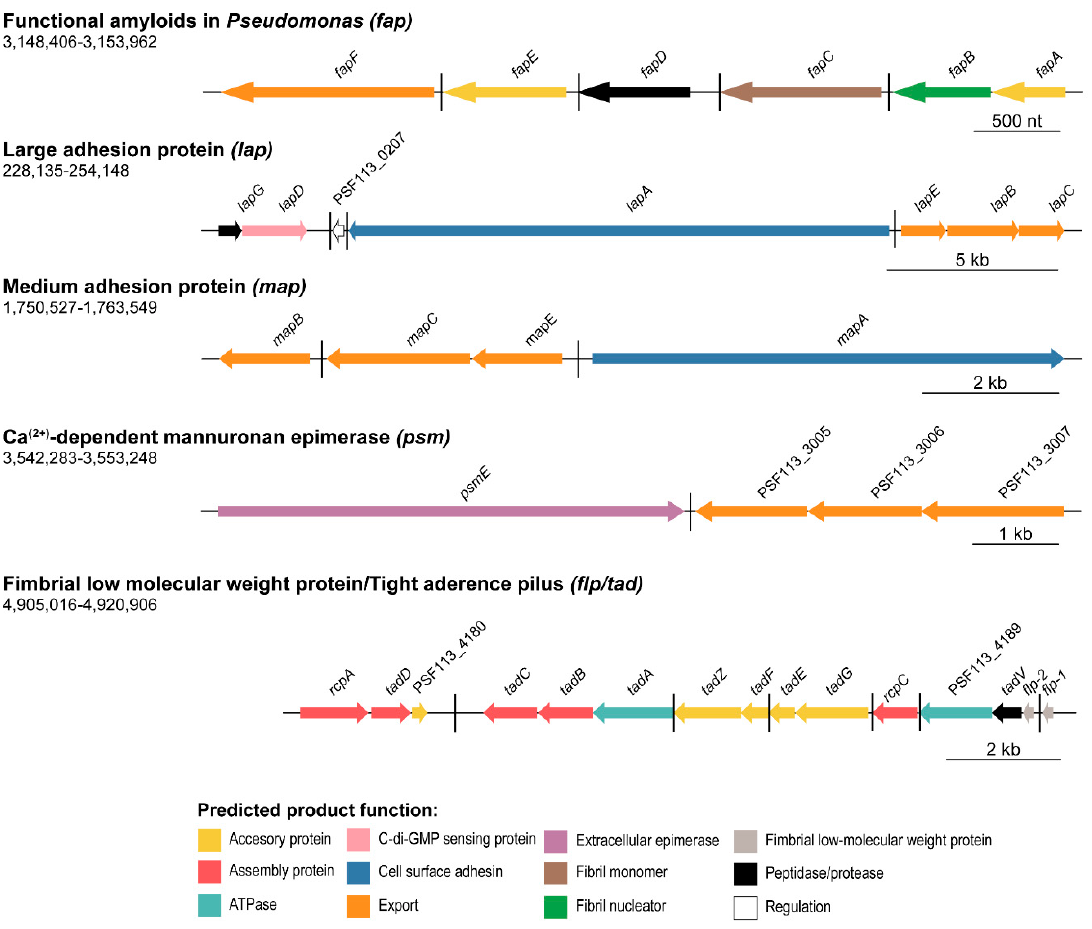
Figure 2. Protein or proteinaceous structure-encoding clusters organization in P. fluorescens F113 genome. Schematic representation of the five putative extracellular protein or proteinaceous structure-encoding clusters in F113. Genes are scaled and colored according to the putative function of their encoded proteins as shown in the legends. Arrow direction indicates the orientation of the gene. The name for each gene is represented above the corresponding arrow. Genomic coordinates are shown below the polysaccharide (gene cluster) name. Black horizontal bars depict different transcriptional regulatory units.